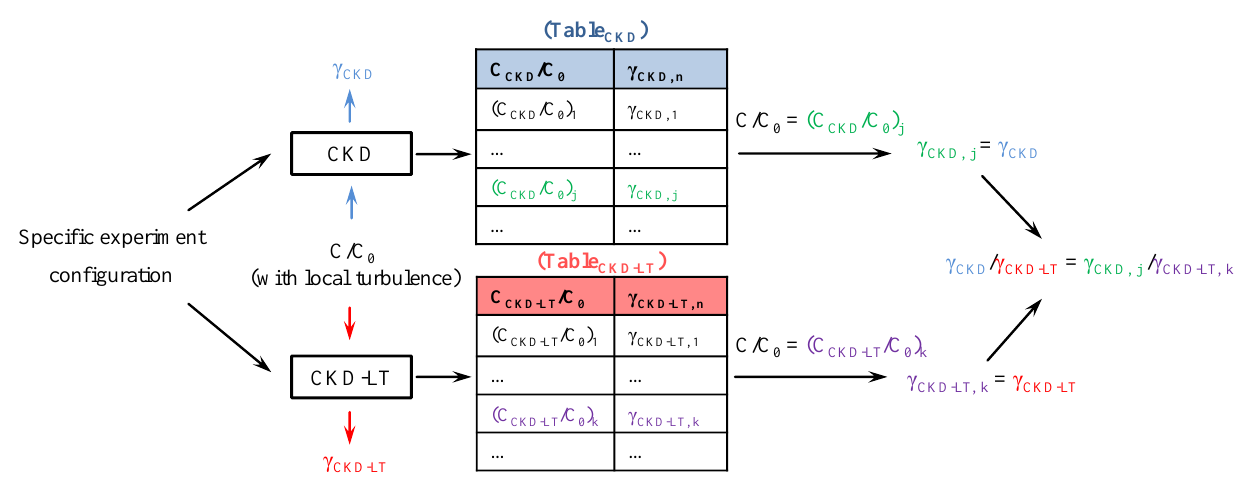
Figure D1. Schematic of the derivation principle for γ CKD /γ CKD-LT . The abbreviations and symbols are explained in Appendix